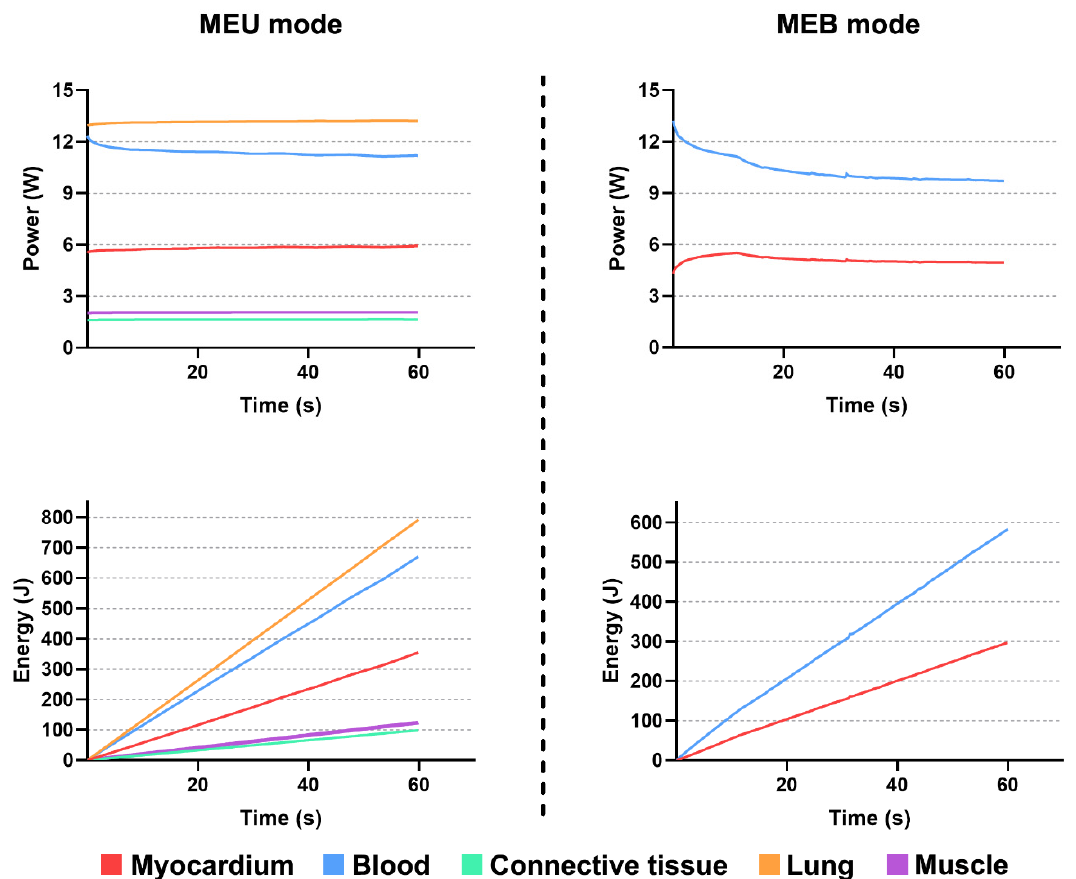
Figure 8. Radiofrequency (RF) power generation and heat energy absorption by different material of the ablation model in the MEU and MEB modes during 60 s of RFCA.